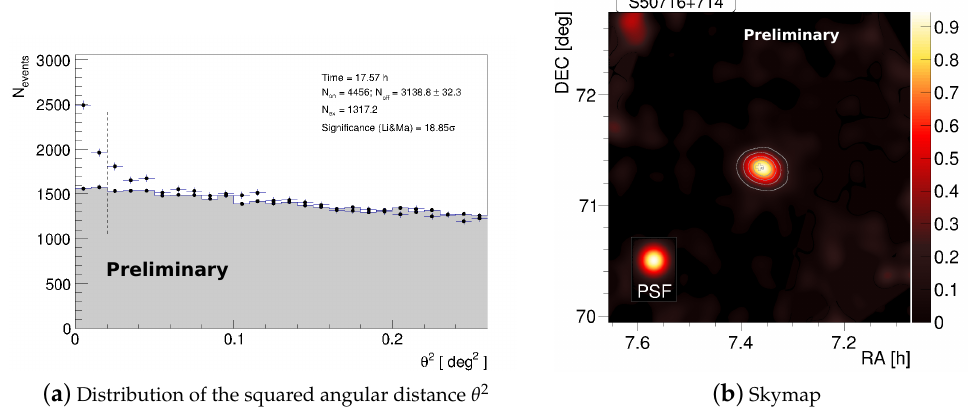
Figure 1. Distribution of the squared angular distance θ 2 between the reconstructed source position and the nominal source position (points) or the background estimation position (shaded area) for S5 0716+714 ( a ) and VHE skymap of the source ( b ). The color bar indicates the relative flux. The contours indicate significance in steps of 5 σ